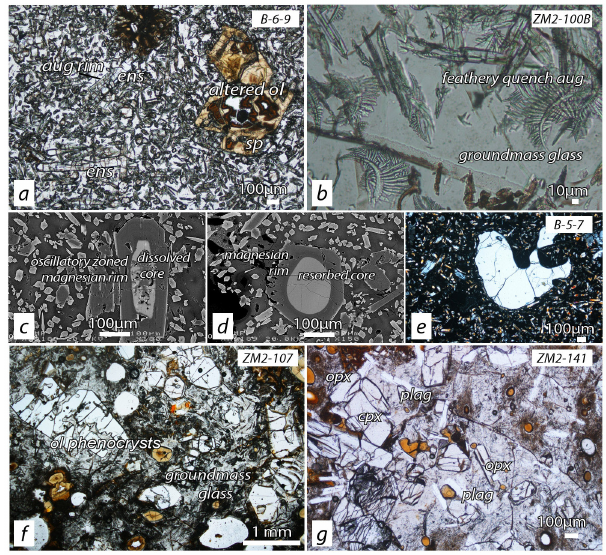
Figure 4. Microphotographs showing the textures of Zambales boninite and boninite-series volcanics. (a) High-silica boninite (HSB) with altered olivine and abundant elongate enstatite mi- crophenocrysts with augite rims (plane polarized light). (b) Char- acteristic feathery clinopyroxene in groundmass glass, HSB (plane polarized light). (c) Oscillatory zoning in magnesian rim of en- statite xenocryst with dissolved core, HSB (BSE). (d) Reverse zon- ing in enstatite xenocryst with resorbed core, HSB (BSE). (e) Em- bayed quartz xenocryst, HSB (crossed polars). (f) Low-silica boni- nite (LSB) with fresh olivine phenocrysts in glassy groundmass (plane polarized light). (g) Plagioclase, orthopyroxene and clinopy- roxene microphenocrysts in LSB-series basaltic andesite tuff brec- cia matrix (plane polarized